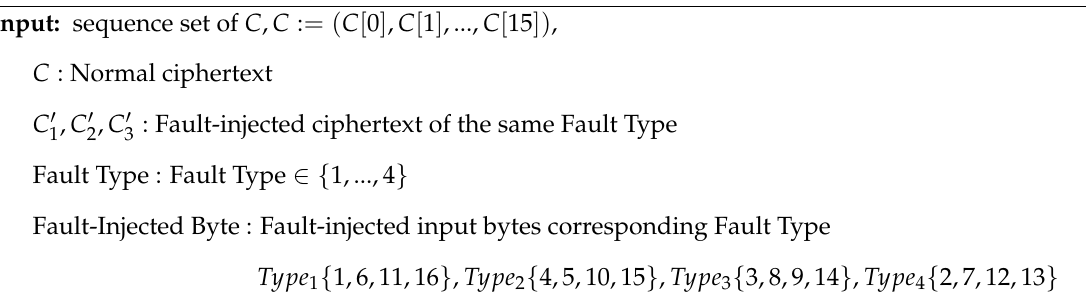
Algorithm 1 Key recovery